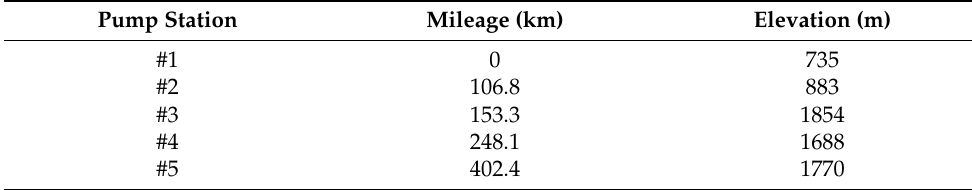
Table 3. The positions of the pump stations.